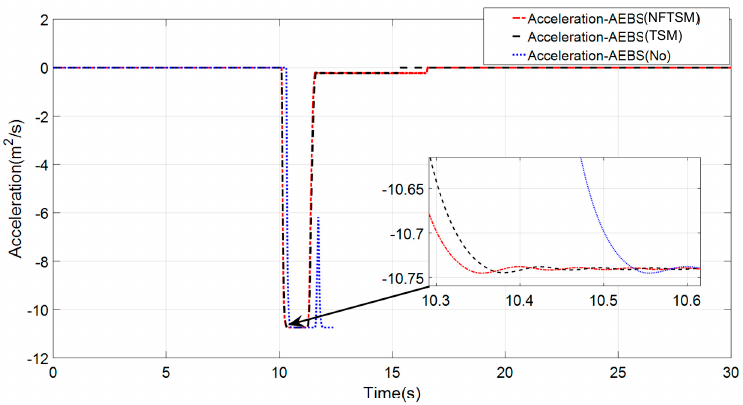
Figure 3. Comparison of relative distance.